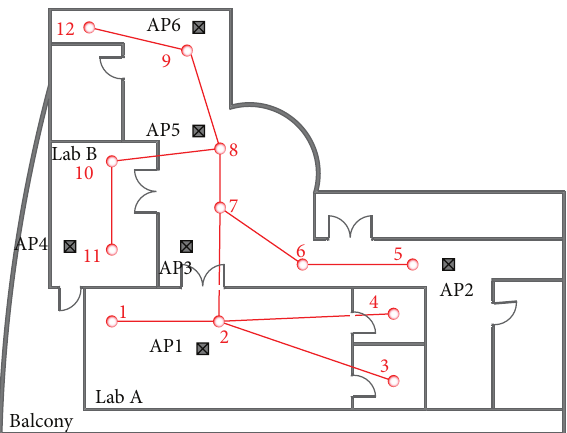
Figure 4: Reference point selection and graph